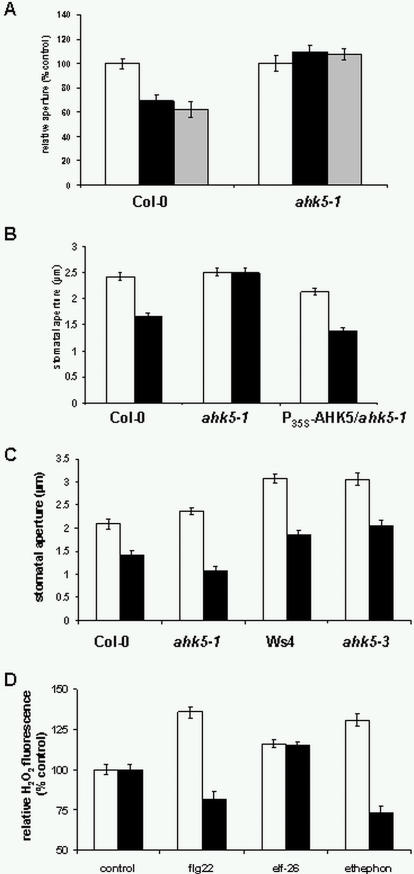
Guard cells of ahk5 mutant show a differential response to PAMPs.(A) Stomatal aperture of wild type (Col-0) and ahk5-1 3 h after exposure to P. syringae pv. DC3000 (black bars) or hrpA− mutant (grey bars). White bars, mock-treatment. (MgCl2). (B) Stomatal closure of wild type (Col-0), ahk5-1 and ahk5-1 transformed with a P35S-AHK5 construct after a 3 h treatment with either buffer (white bars) or 10 nM flg22 peptide (flg22, black bars). (C) Stomatal closure of wild type (Col-0, Ws4), ahk5-1 and ahk5-3 in response to a 3 h treatment with buffer (white bars) or 1 μM elf26 peptide (elf26, black bars). Data are expressed as mean +/− S.E. from 3 independent experiments (n = 60 guard cells), p<0.05 (student's t-test) versus appropriate controls. (D) H2O2 fluorescence from epidermal peels of wild type (Col-0, white bars) and ahk5-1 (black bars) treated for 15 min with 10 nM flg22, 1 μM elf26 or for 30 min with 100 μM ethephon. Fluorescence intensity was quantified as described in methods. Data are expressed as relative fluorescence (% control values) +/− S.E. (n = 90–122 guard cells for each treatment).